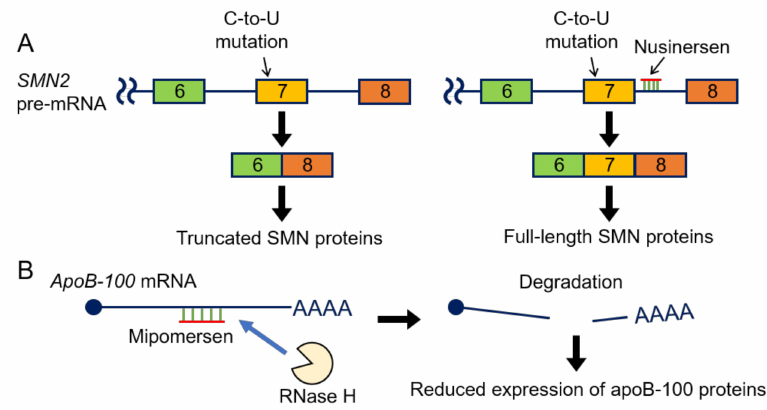
Figure 5. Antisense oligonucleotides (ASOs) in clinical use. ( A ) Nusinersen binds to a splicing regulatory sequence called intronic splicing silencer-N1 (ISS-N1) within intron 7 of SMN2 pre-mRNA, and enhances the inclusion of exon 7, resulting in the production of SMN2 mRNA coding the full-length SMN protein. ( B ) Mipomersen binds to ApoB-100 mRNA and causes its degradation, mediated by ribonuclease H (RNaseH). SMN2 : survival of motor neuron 2: centromeric ; SMN: survival of motor neuron; ApoB-100 : apolipoprotein B-100